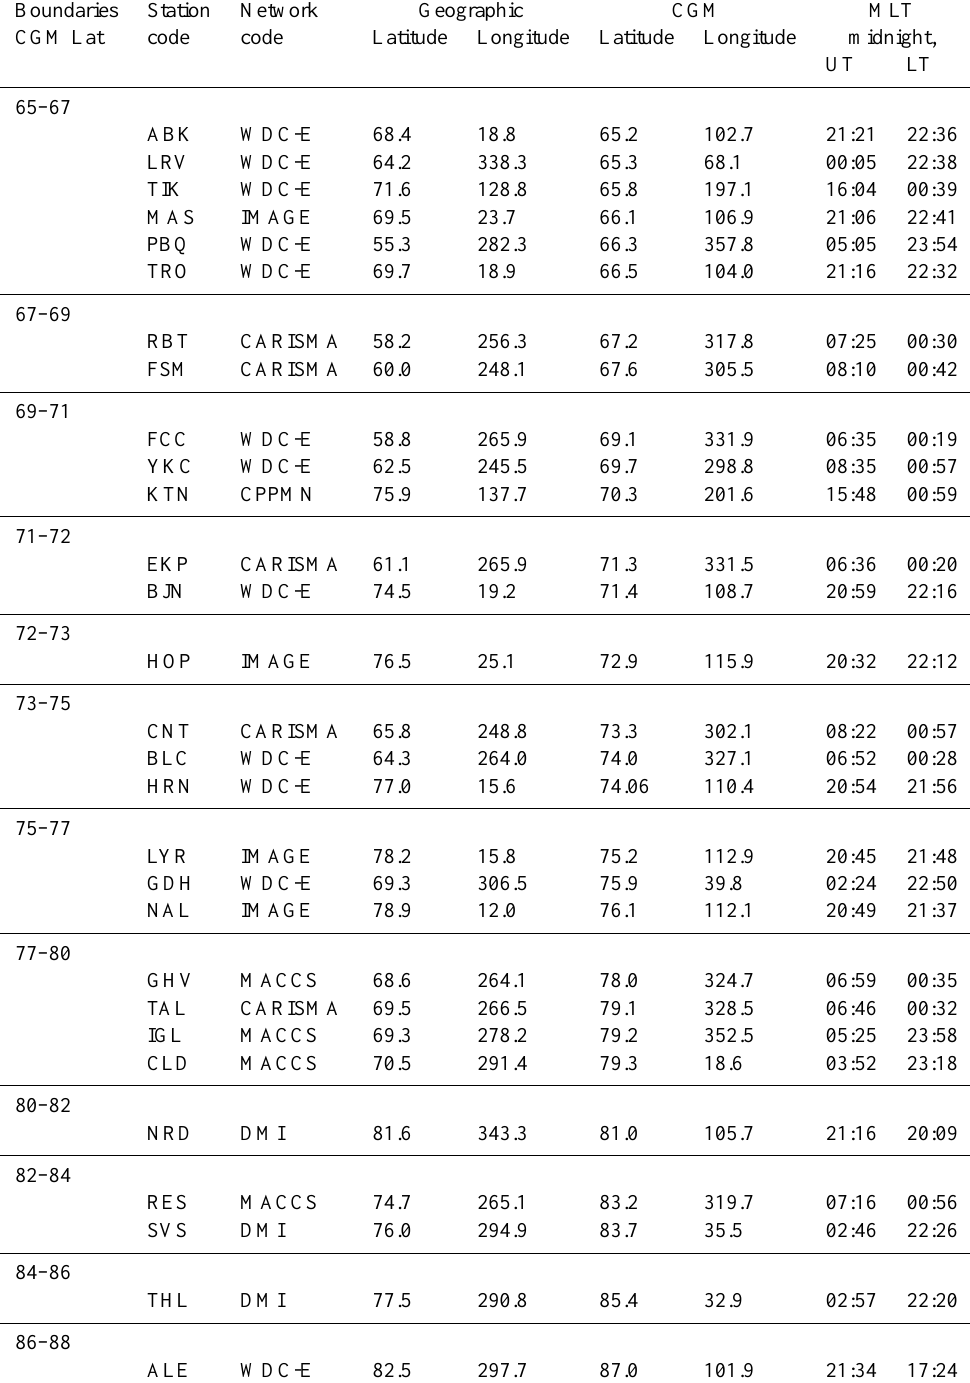
Table 1. Stations and latitude zones.